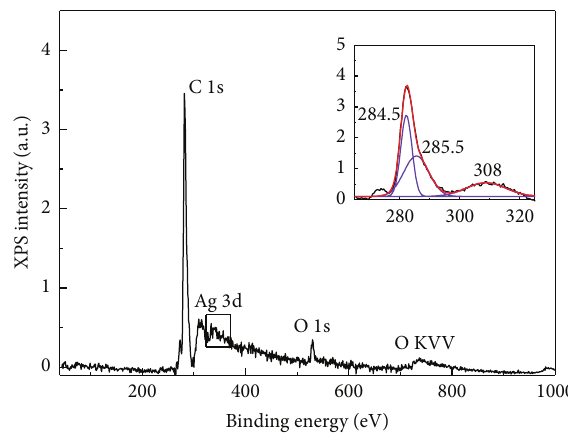
Figure 3: XPS survey spectrum taken from Ag/CNT composites. Inset: Gaussian analysis of C 1s